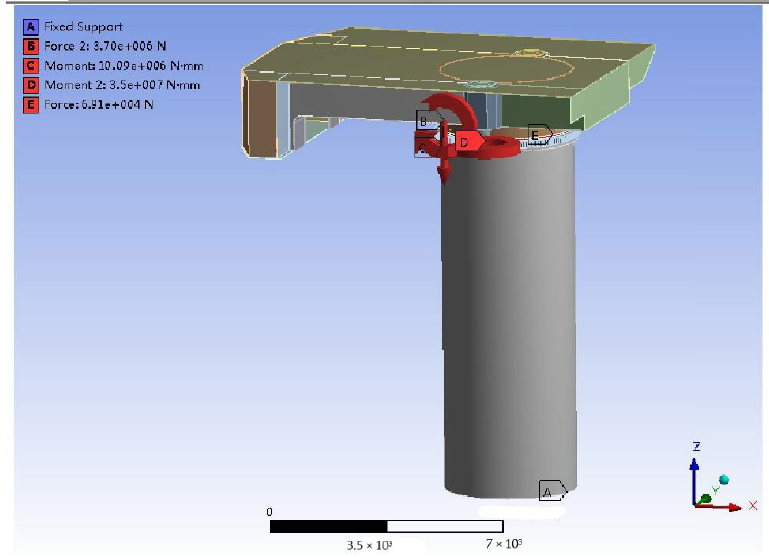
Figure 9. Case of load application and restraint.